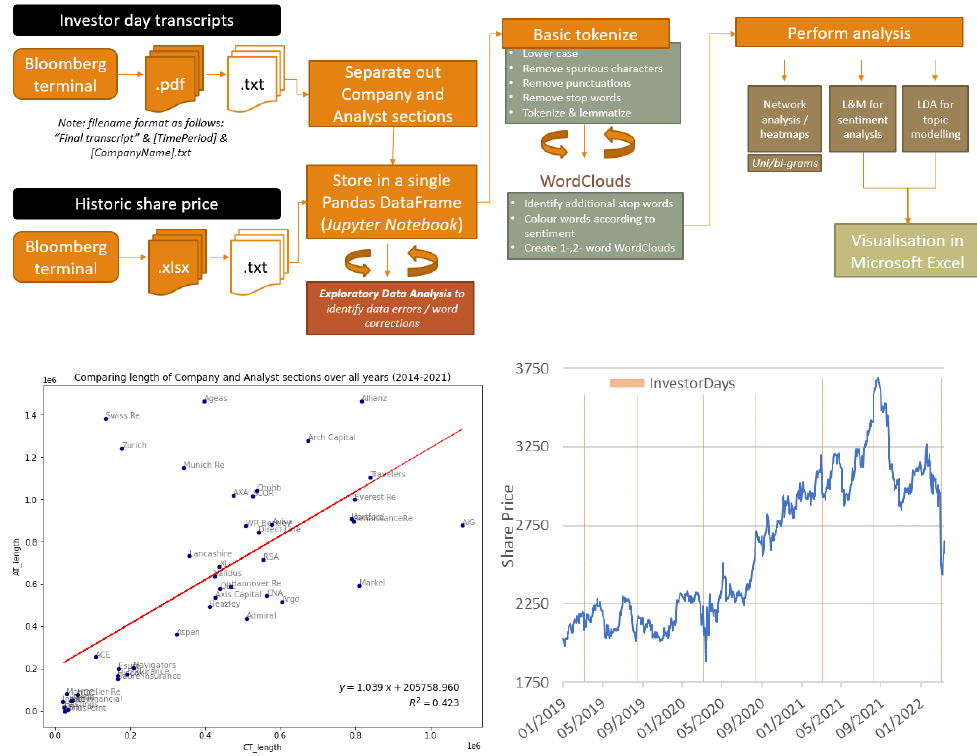
Figure 1. Top : Flowchart of text analysis for keyword extraction, sentiment analysis, and network building from the investor transcripts. Bottom Left : Comparing the length of Company and An- alyst sections overall years (2014–2021). Bottom Right : A smaller sample of Admiral Share Price fluctuations with Investor-Day